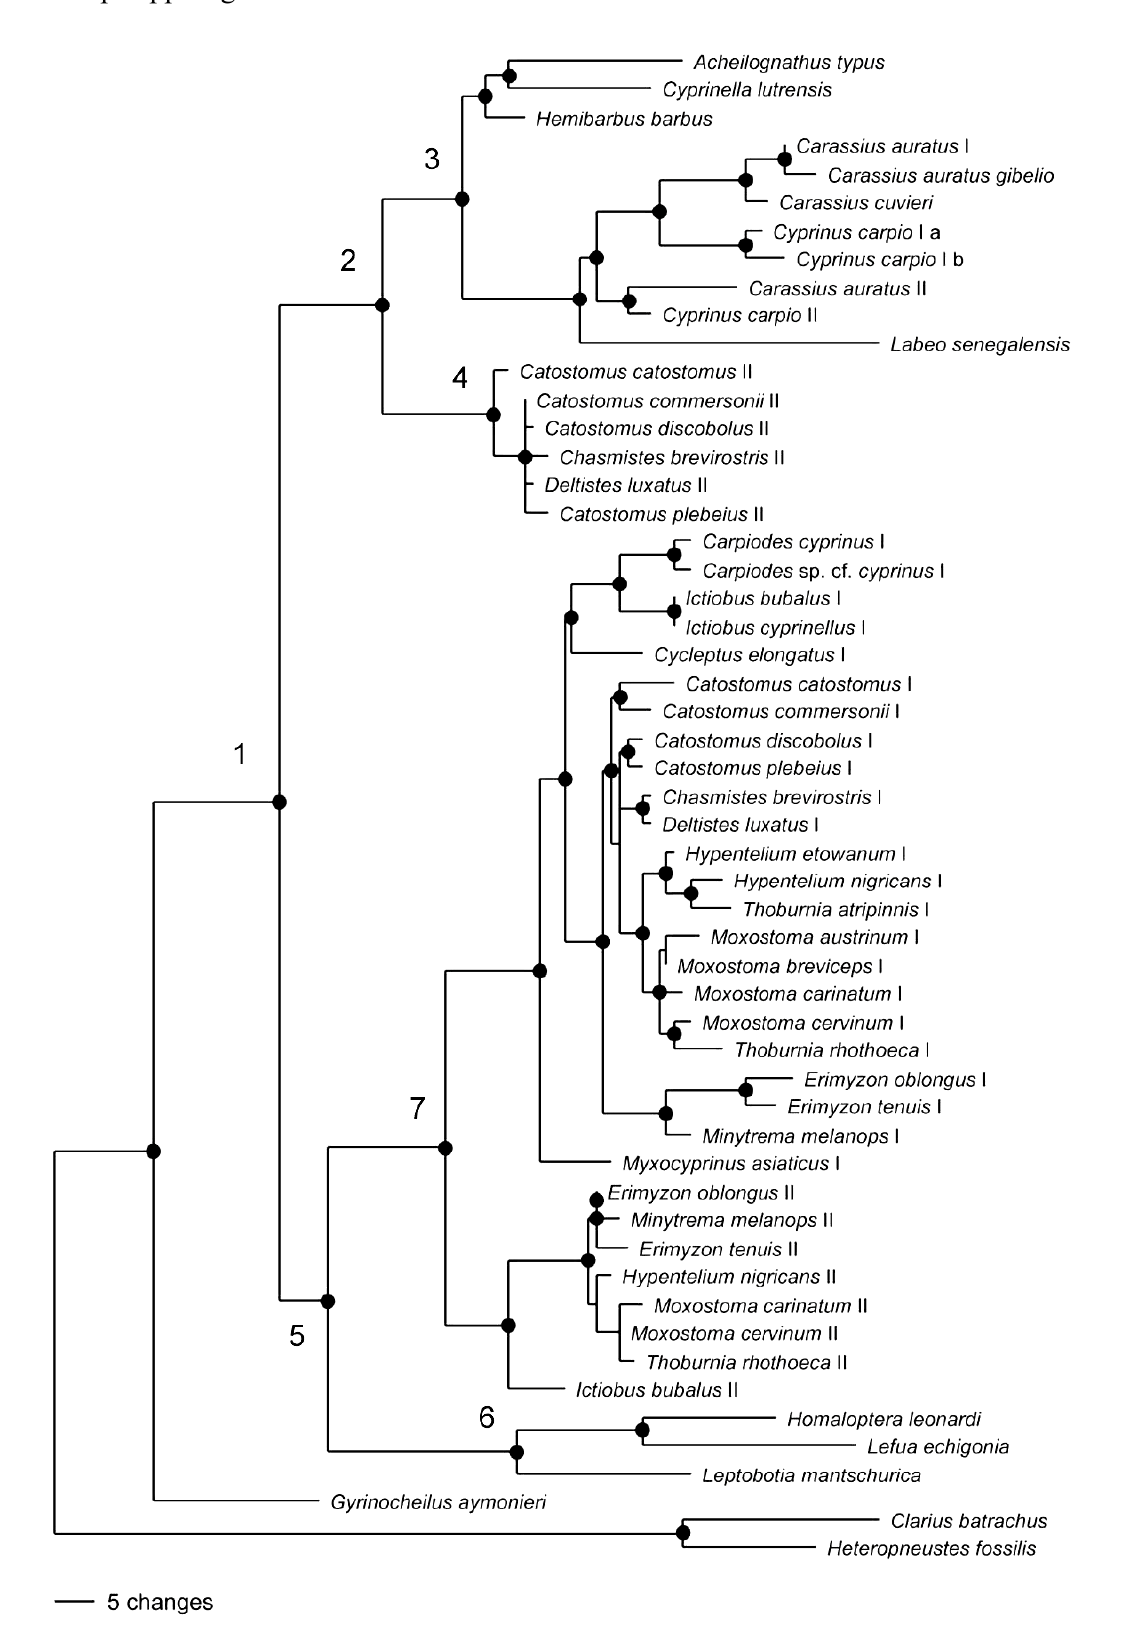
Figure 1. Majority rule consensus tree of 2000 bootstrap replicates from maximum parsimony analysis of cypriniform GH sequence data. Filled circles at nodes represent bootstrap support greater than